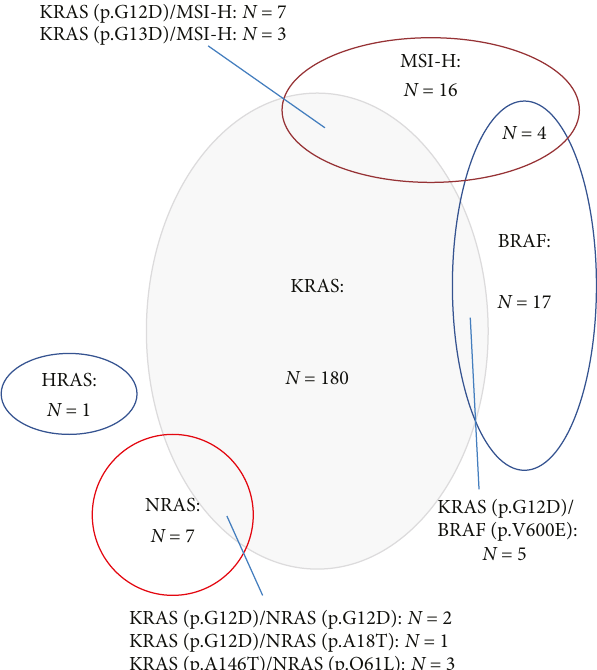
Figure 1: Set diagram illustrates the associations among KRAS , NRAS , HRAS, and BRAF mutations and MSI-H status. Mutations in KRAS and NRAS are not mutually exclusive, and neither are KRAS and BRAF . MSI-H status cooccurred with KRAS or BRAF mutations. MSI-H: microsatellite